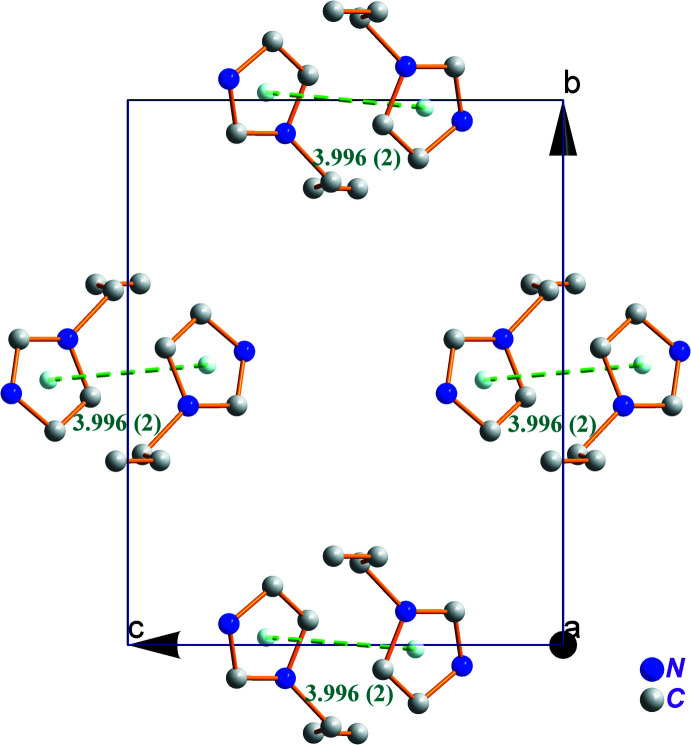
The π–π inter­actions between organic cations in (C6H9N2)2[SnCl6]. H atoms are omitted for clarity.